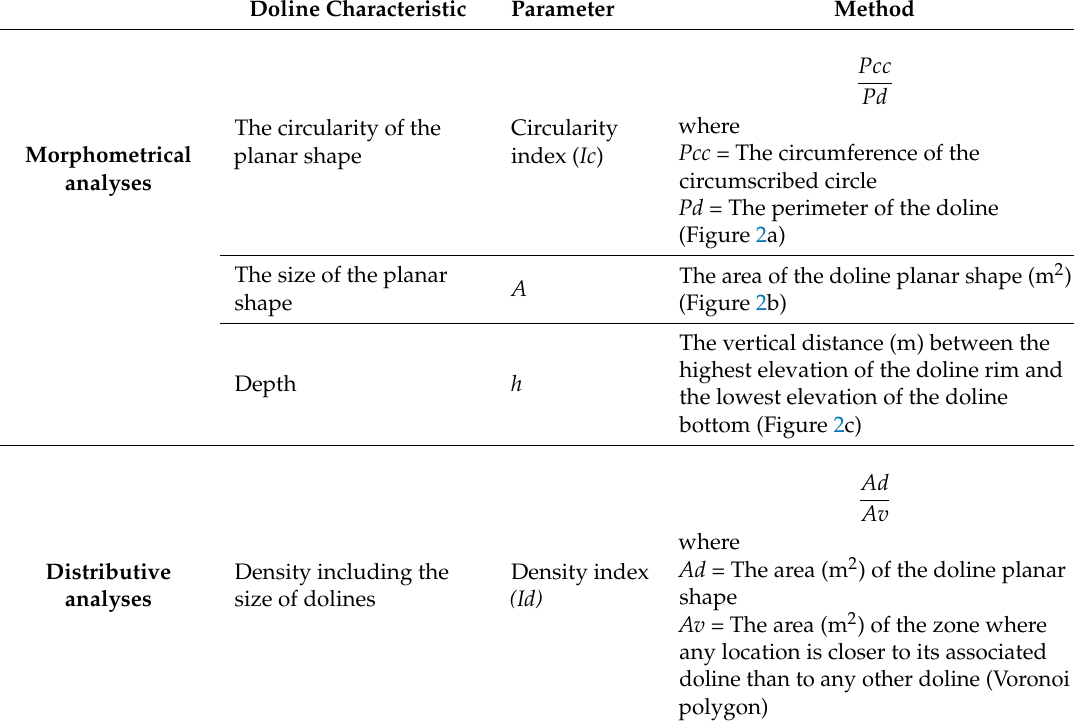
Table 2. The investigated characteristics of depressions on conglomerates and methods employed in morphometrical and distributive